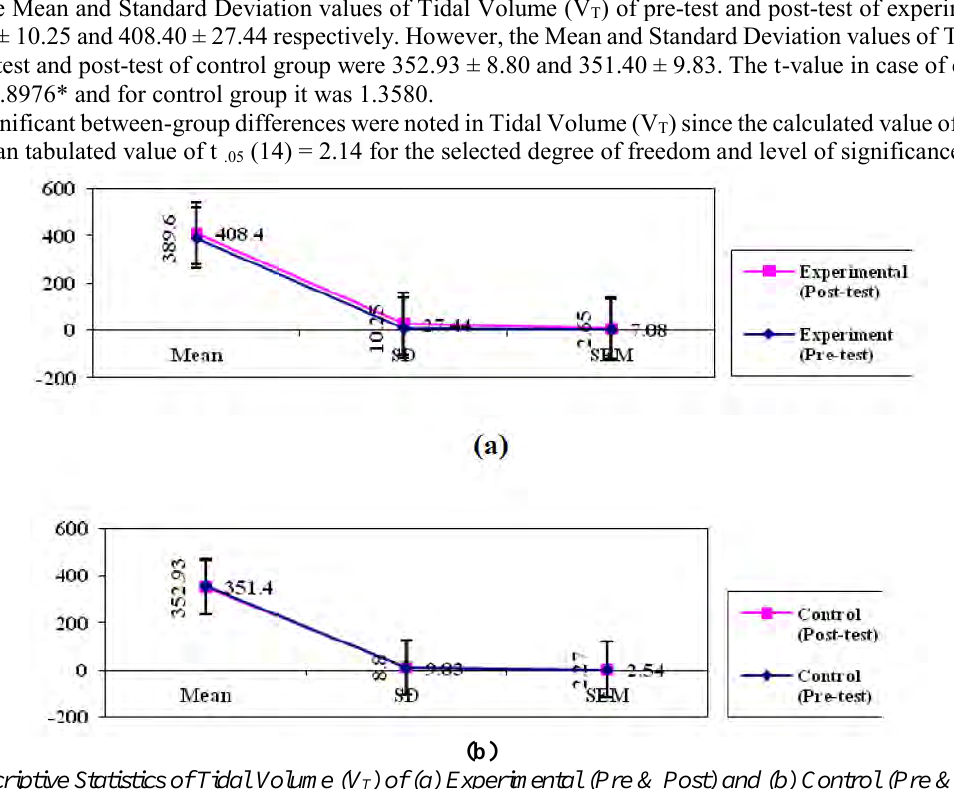
Fig. 8. Descriptive Statistics of Tidal Volume (V T ) of (a) Experimental (Pre & Post) and (b) Control (Pre & Post) group of University Level